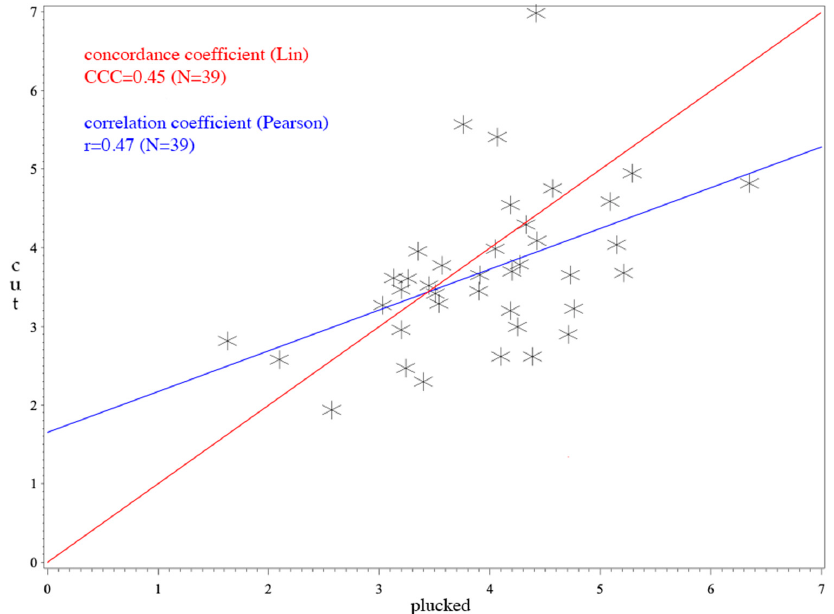
Figure 3. CCC and Pearson’s correlation coefficient of Anser ; p -value for Pearson’s correlation coefficient: p = 0.0023; the outlier was excluded which leads to a total number of 39 individuals. The x-axis shows the corticosterone values of plucked feathers. The y-axis represents the values of cut feathers. The red line illustrates the concordance coefficient. The correlation coefficient is expressed in the blue line. The Bland–Altman plot, also known as the “di ff erence plot”, displays the agreement of two measurement techniques [58,59]. The di ff erences between the methods per sampling pair are plotted in a scatter diagram against the respective means of values (see Figures 4 and 5). The middle